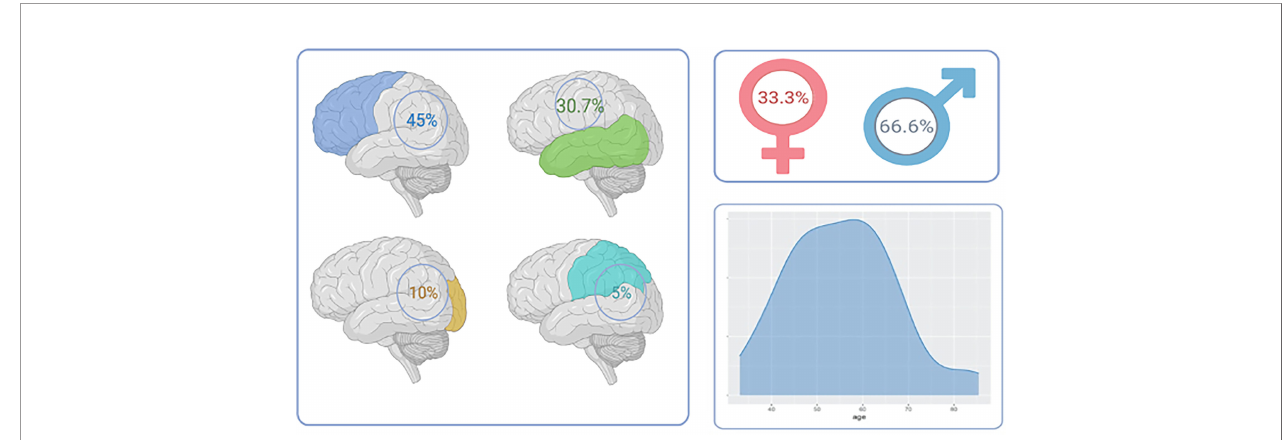
FIGURE 2 | Tumor location and patient demographics in GBM-related hydrocephalus cohort. Left panel: Tumor location showing a predominance of GBM in the frontal lobe followed by temporal tumors. Right upper panel: sex distribution. Right lower: age